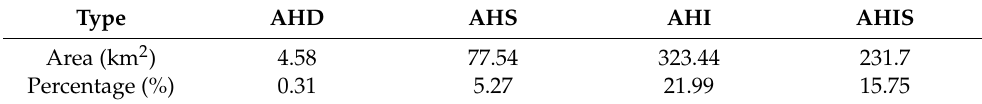
Table 5. Statistics of different change types of anthropogenic heat from 2004 to